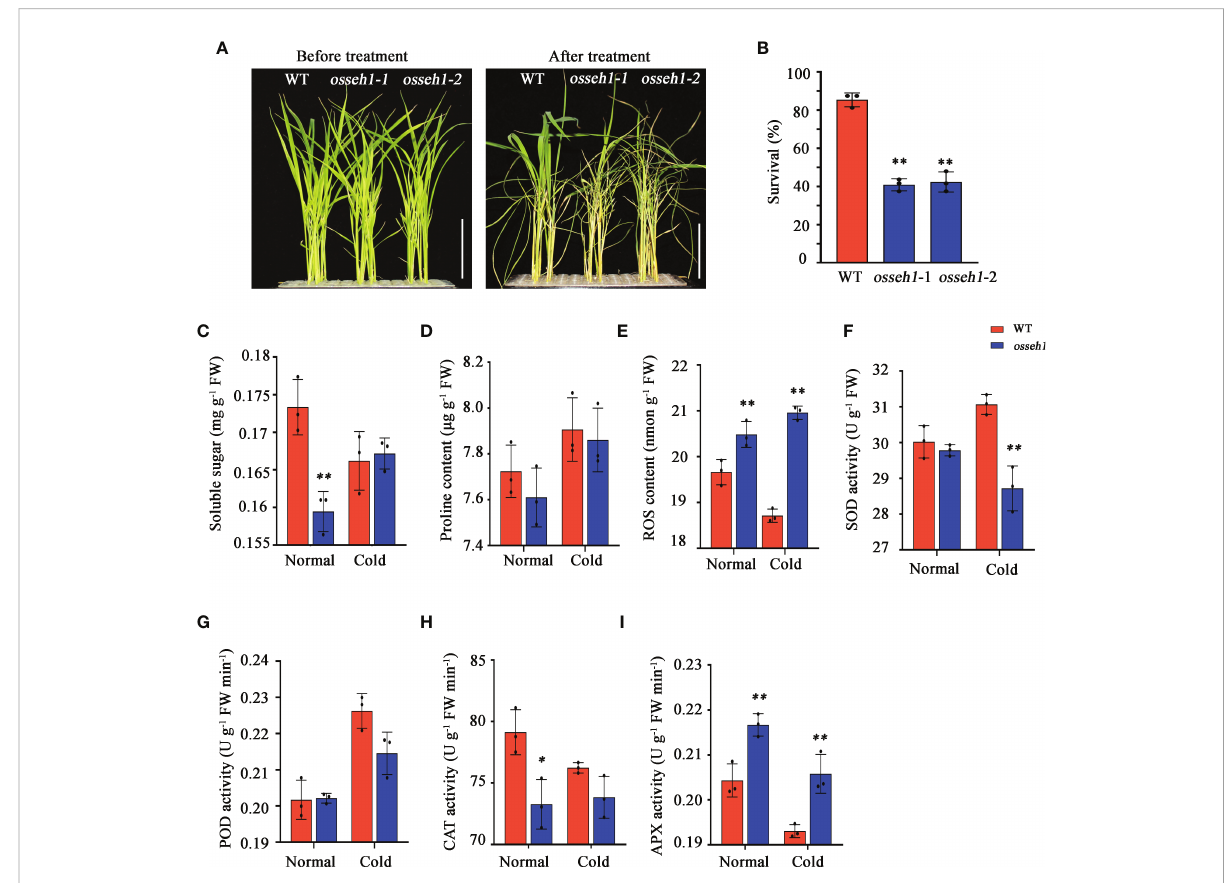
FIGURE 1 Comparison of morphological and physiological indexes between osseh1 knock-out lines and WT plants under cold stress. (A) Phenotypes of osseh1 knock-out lines and WT plants under cold tolerance. (B) Survival rates of osseh1 knock-out lines and WT plants recovered for 7 days after cold treatment. Statistical analysis of (C) soluble sugar, (D) proline content, (E) ROS content, (F) SOD activity, (G) POD activity, (H) CAT activity and (I) APX activity. Data represents means ± SEM (n = 3). *P < 0.05, **P < 0.01. Scale bars, 5cm. WT, wild type; osseh1 , knockout lines; ROS, reactive oxygen species. SOD, superoxide dismutase; POD, peroxidase; CAT, catalase; APX, ascorbate